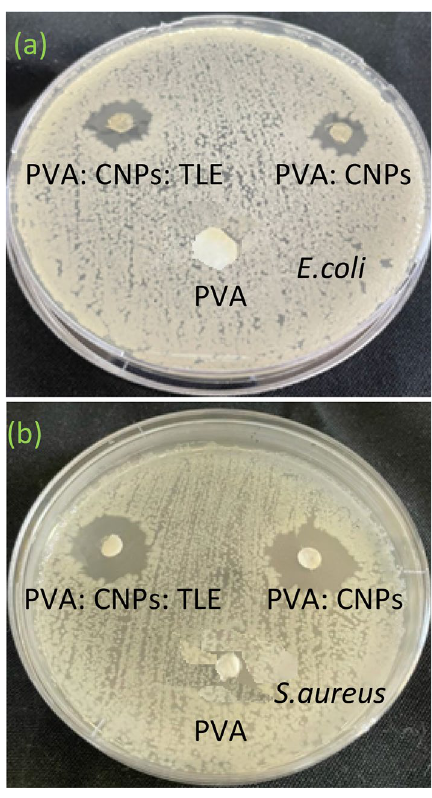
Figure 7. ( a ) Inhibition zone of PVA, PVA: CNPs, PVA: CNPs: TLE against E. coli , ( b ) Inhibition zone of PVA, PVA: CNPs, PVA: CNPs against S. aureus.